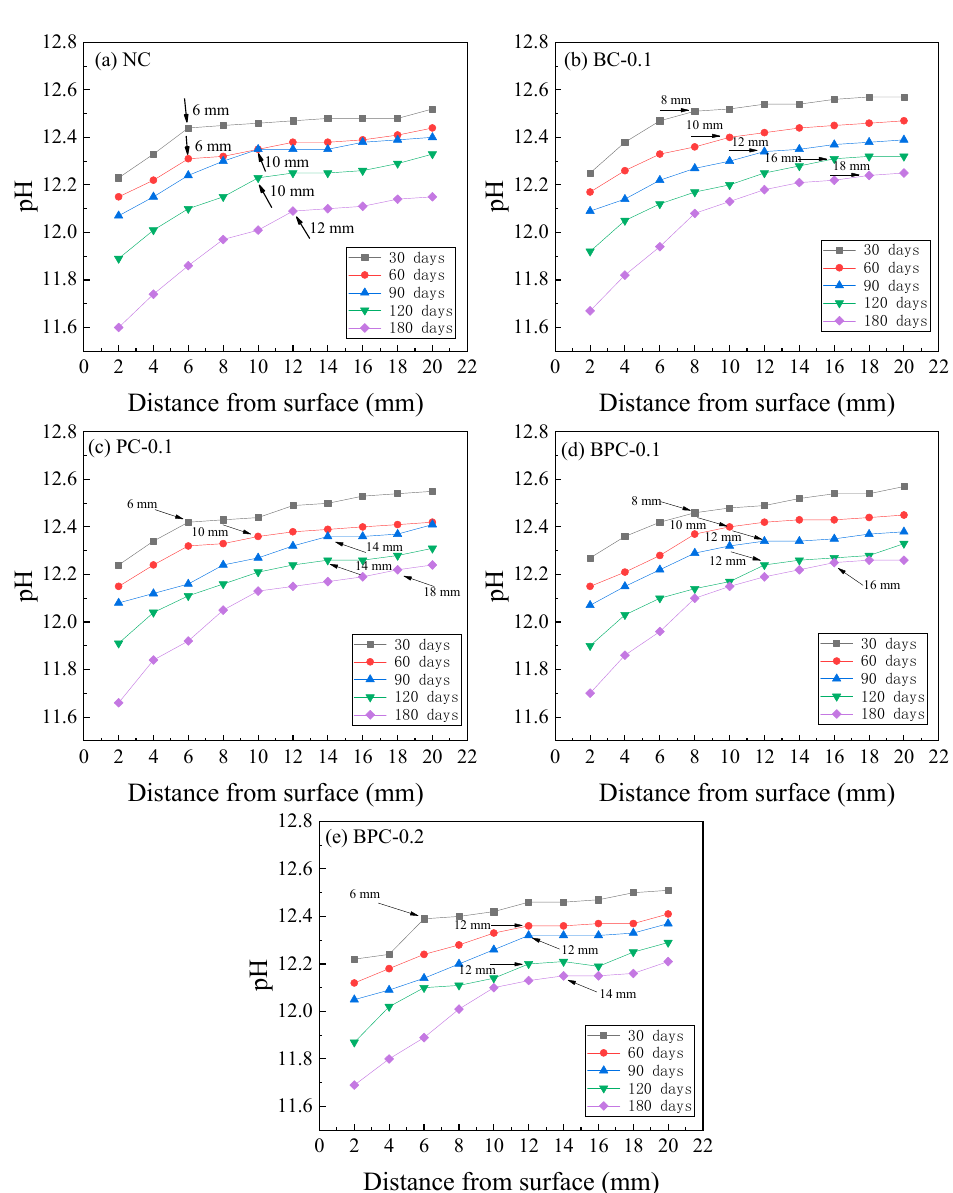
Figure 7. pH distribution of the HBPRC: ( a ) NC; ( b ) BC-0.1; ( c ) PC-0.1; ( d ) BPC-0.1; ( e ) BPC-0.2.